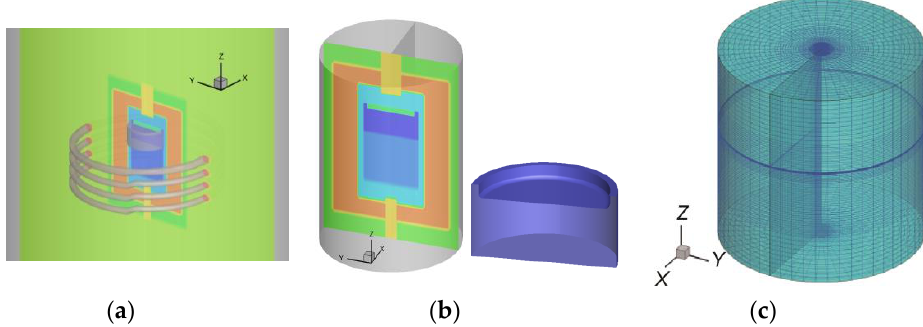
Figure 1. Silicon carbide crystal growth furnace and its three-dimensional mesh. ( a ) Physical model for electromagnetic field; ( b ) physical model for temperature field; ( c ) mesh for the furnace. Table 1. Physical properties of materials of SiC growth furnace